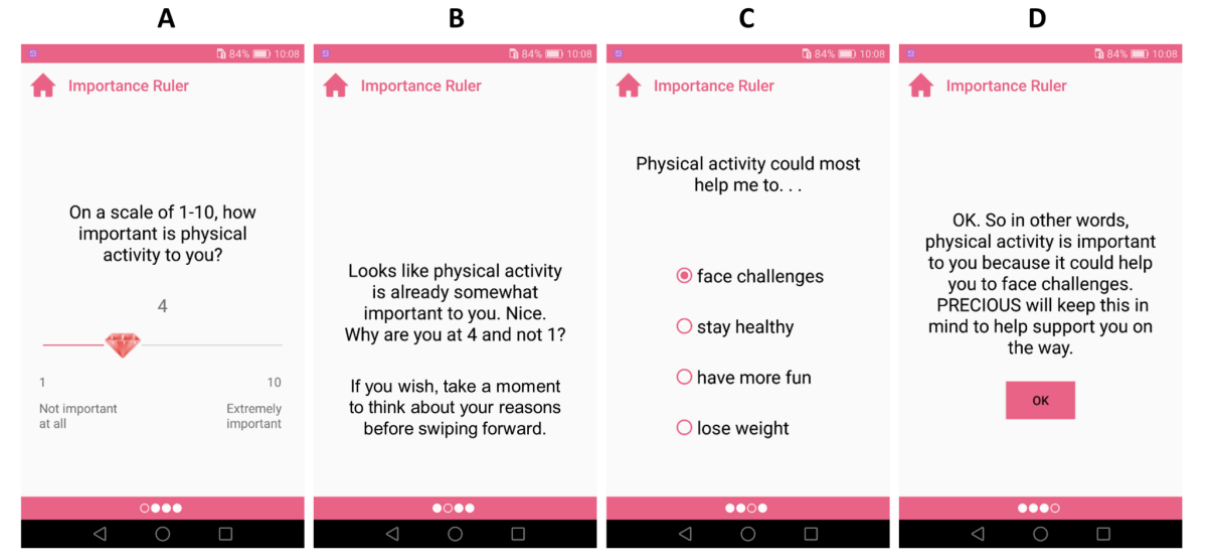
Figure 4. Implementation of the Importance ruler tool. Screen A shows the importance ruler itself. Screen B shows a follow-up question from the individual’s initial response and a prompt to help users better introspect about why they chose a particular number on Screen A. Screen C shows a selection of possible positive outcomes of physical activity, populated from the choices made previously in the What Do I Want? tool. Screen D shows a reflection of the user’s chosen responses on Screen C.